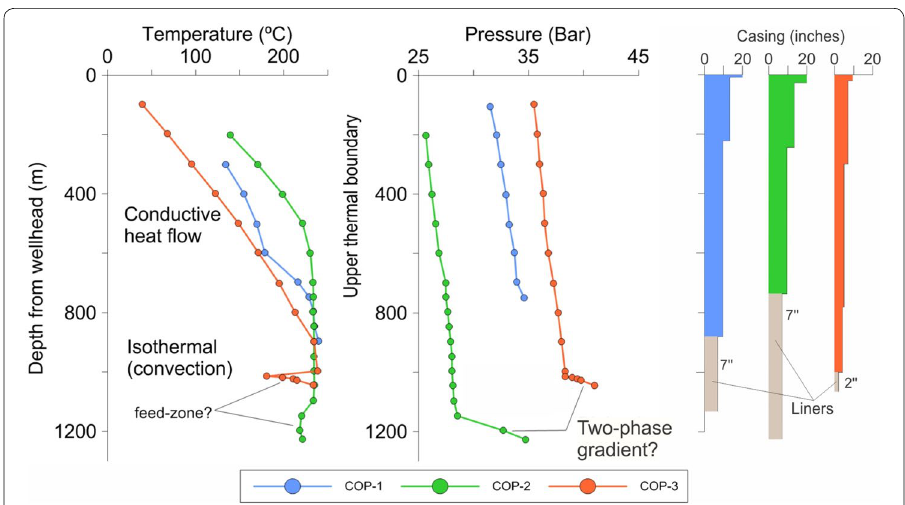
Fig. 3 Temperature and pressure profiles at no-flow condition from the wells of Copahue (see well locations in Fig. 1; JICA 1992). The casing-liner distribution for each well is also